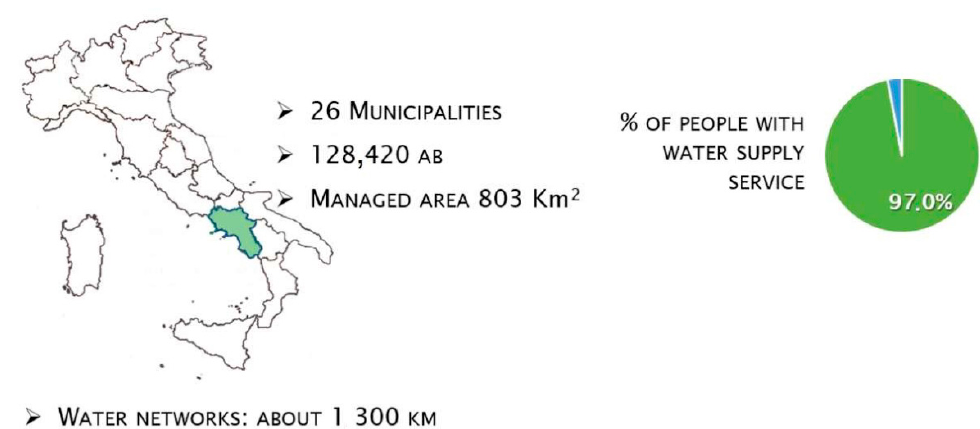
Figure 3. The most relevant information about the area managed by the Water Service operator.